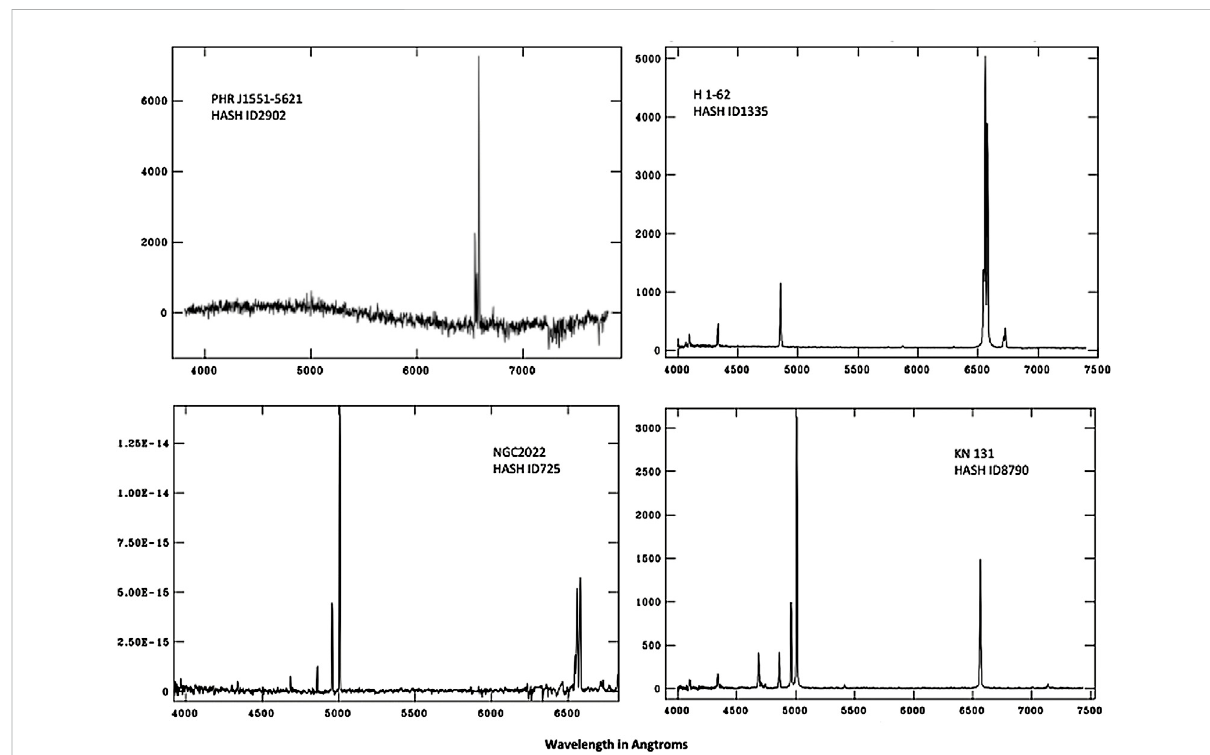
FIGURE 2 Examplespectraoffourbona- fi dePNefromHASHthatdemonstratethespectraldiversityofthePNefamily.Thetopleftspectrumisofevolved bipolar PN PHR J1551-5621 (PN G325.9-01.7) that suffers from extinction in the blue, making detection of [OIII] and H β problematic. It shows a high [NII] to H α ratio ( ~8) and the S/N is modest. The top right example is of a compact, VLE PN H 1 – 62 (PN G000.0-06.8) where there is no [OIII] detectable in theblue onlythe Balmer series. However,in thered the[NII] to H α ratio is much greater than seen inHII regions while the [SII]line ratio indicates high electron density. The bottom left is of PN KN 131 (PNG162.9-01.6), an evolved bipolar of high excitation, as evident by the prominentHeII4686Åemissionline(whichisitselfastrongPNdiagnostic).Herethe[NII]toH α lineratioisalso > 1.Thisistheonlyspectrumherethat is fl ux calibrated. Finally, in the bottom right, we have the high excitation elliptical shaped PN NGC 2022 (PN G196.6-10.9), where HeII is as strong as H β and the [OIII] lines are very strong. Only H α is prominent in the red with very weak [NII] and [SII], a common occurrence for many high excitation PNe that also tend to be of round